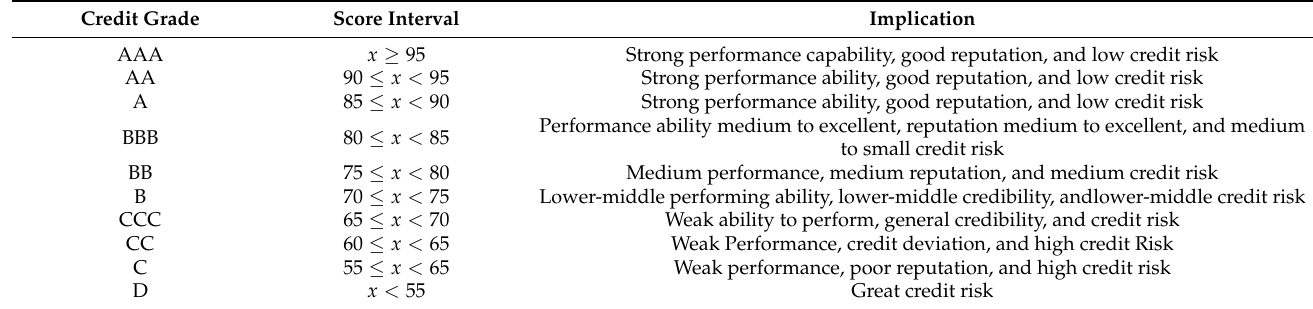
Table 3. Credit Rating of LGFVs.